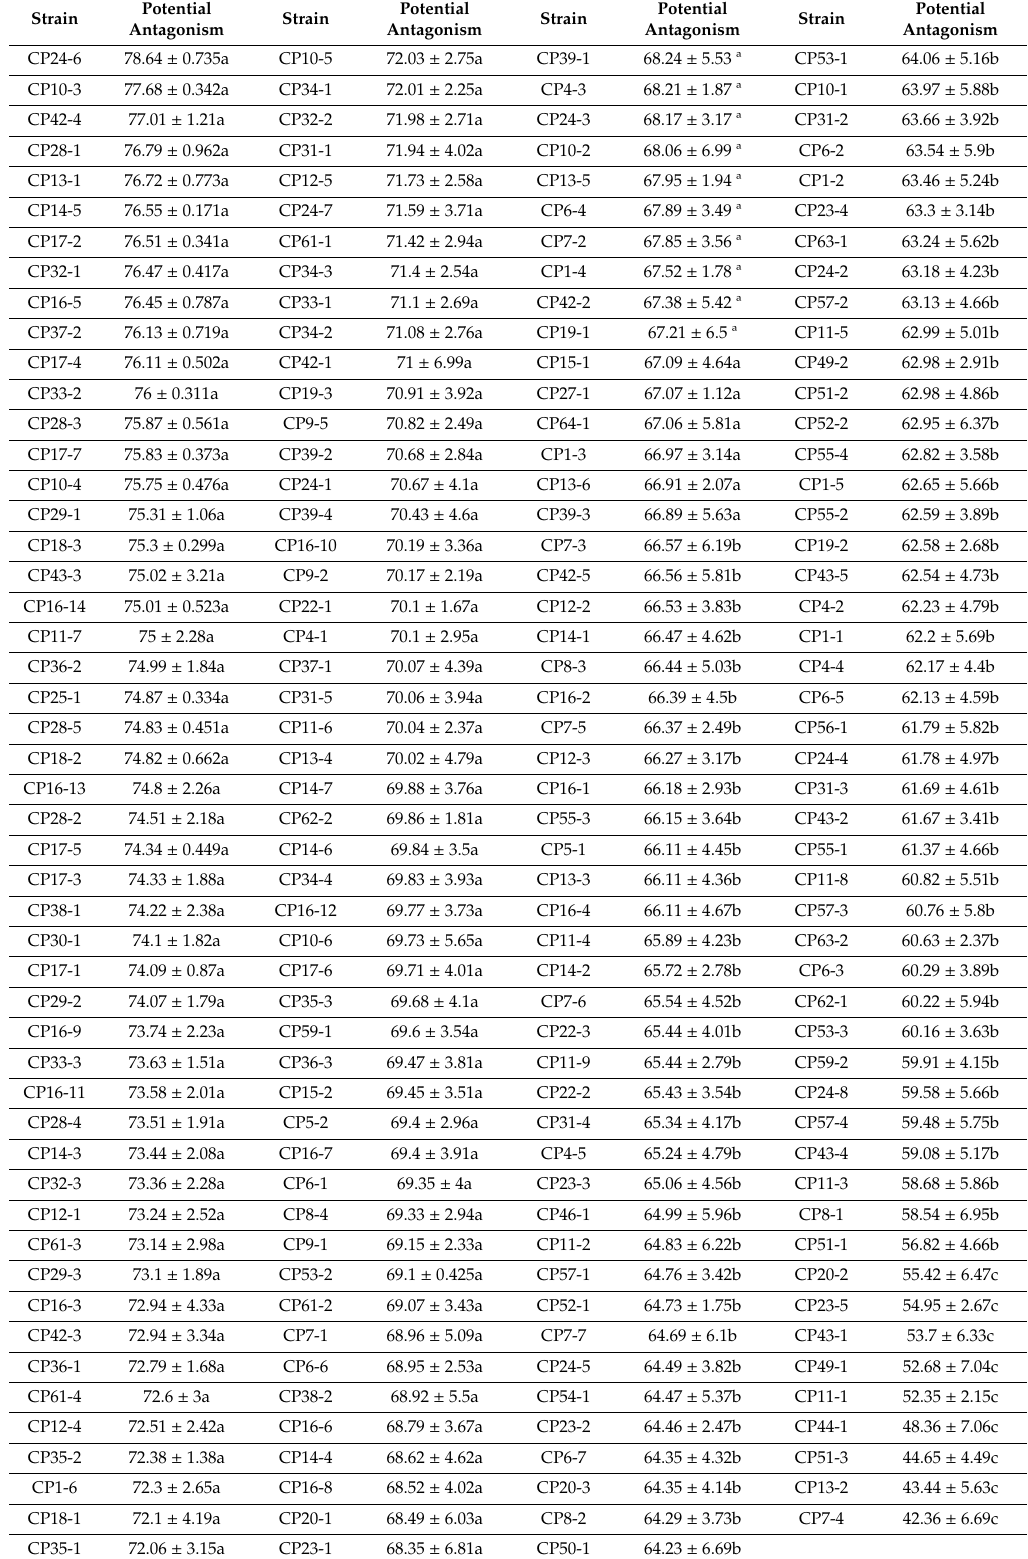
Table 4. Potential antagonism of 199 native strains of Trichoderma from Bagua Province, Amazonas, Peru, evaluated over Moniliophthora roreri ( ± = standard error; average with the same letters are not statistically di ff erent (Scott Knott, α =